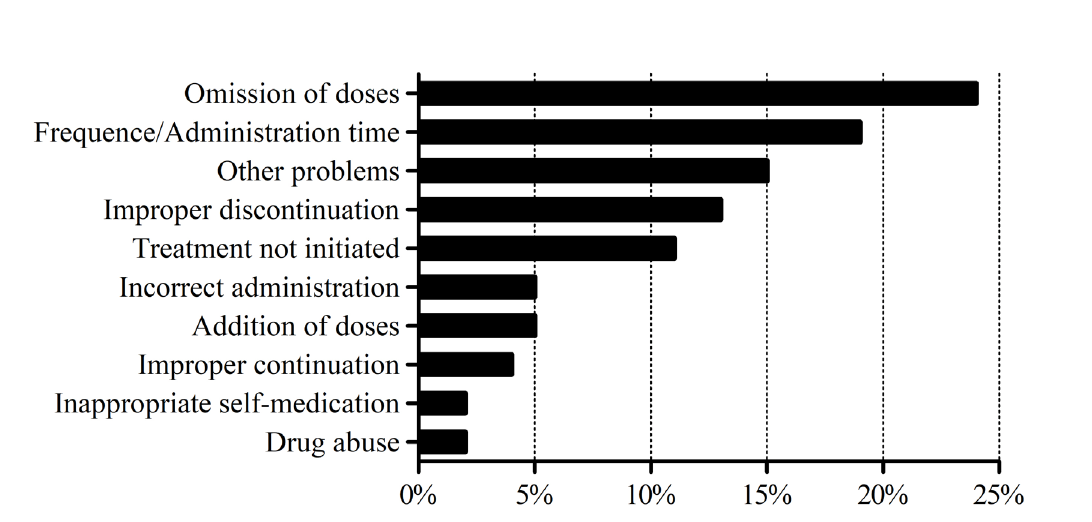
FIGURE 2 - Analysis of DTPs subcategories related to administration and patient adherence to treatment